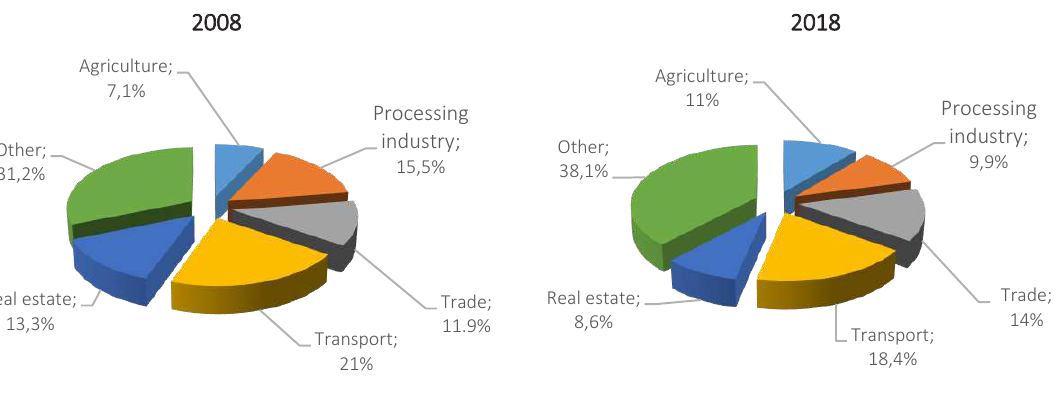
Figure 3. GRP structure in Odesa region in 2008 and 2018